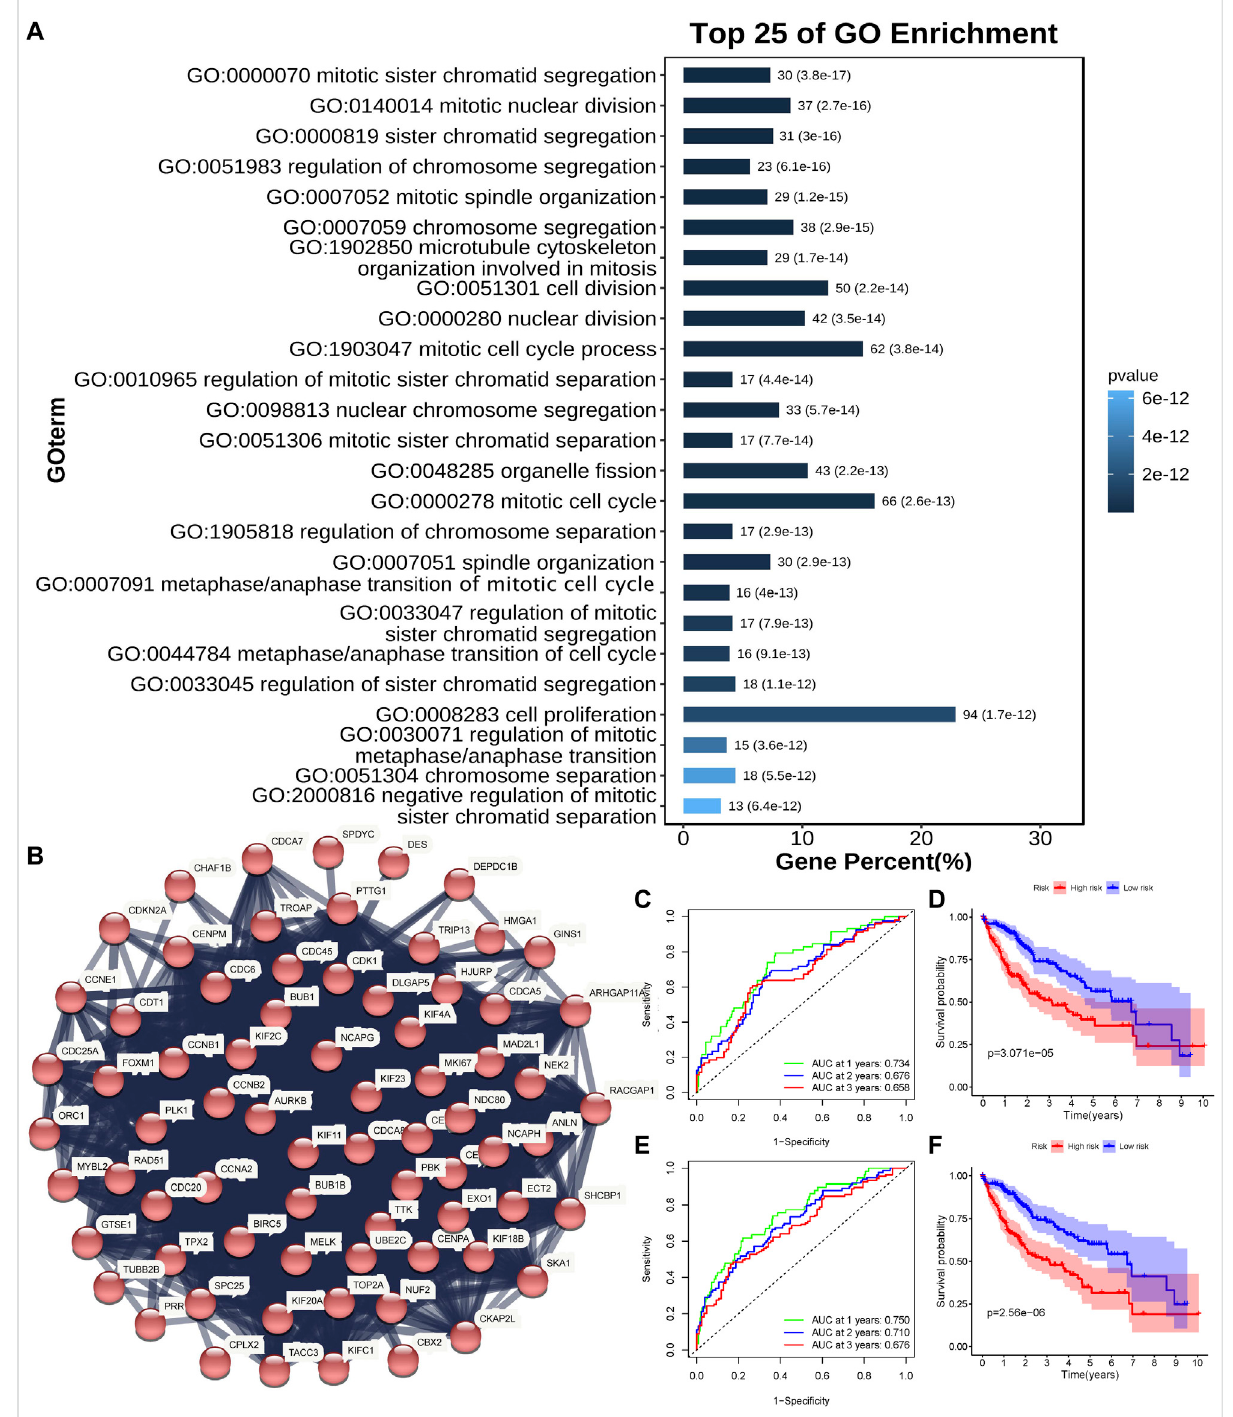
FIGURE 3 Identi fi cation of the mitosis score. (A) Top 25 enriched genes identi fi ed using GO enrichment analysis of DEGs between high- and low-risk groups ( p < 0.05, q < 0.05). (B) PPI network constructed using the STRING database illustrated interactions among the DEGs. The Markov clustering algorithm identi fi ed the biggest cluster. (C,D) AUC of time-dependent ROC curves (C) and Kaplan – Meier curves (D) of the non-normalized mitosis- related gene signature in TCGA. (E,F) AUC of time-dependent ROC curves (E) and Kaplan – Meier curves (F) of the normalized mitosis-related gene signature in